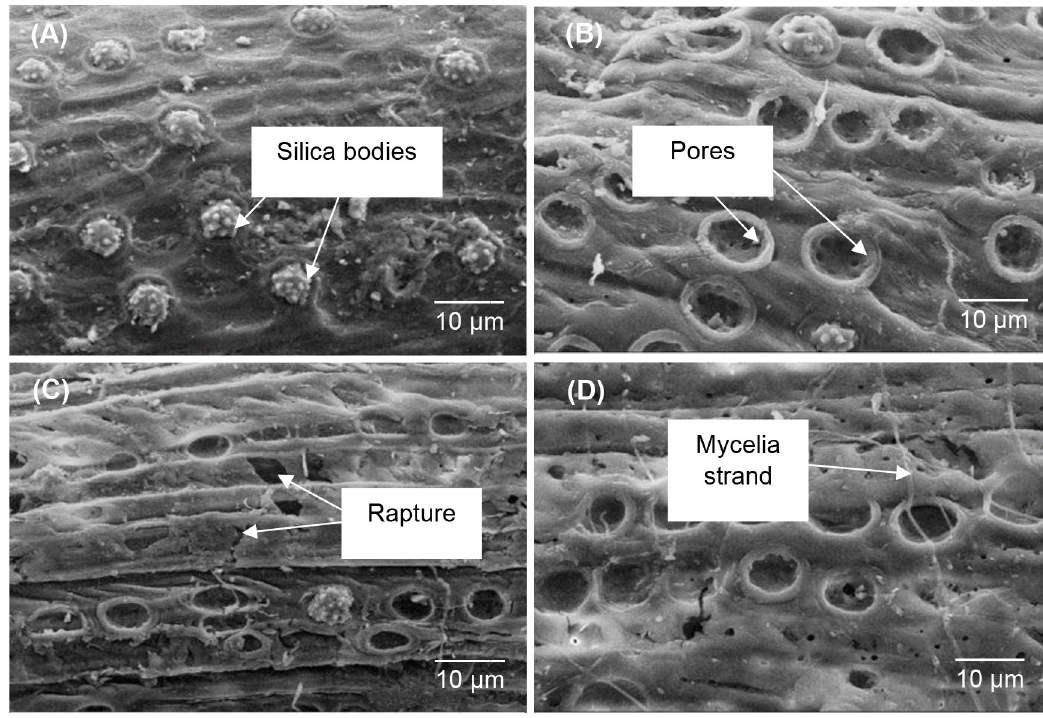
Fig 2. SEM of OPEFB. (A): Silica bodies attached on untreated OPEFB. (B): Pores with detached silica bodies on pre-treated OPEFB. (C): Ruptured and rugged surface of pre-treated OPEFB. (D): Mycelia of the G . lucidum colonised and penetrated the